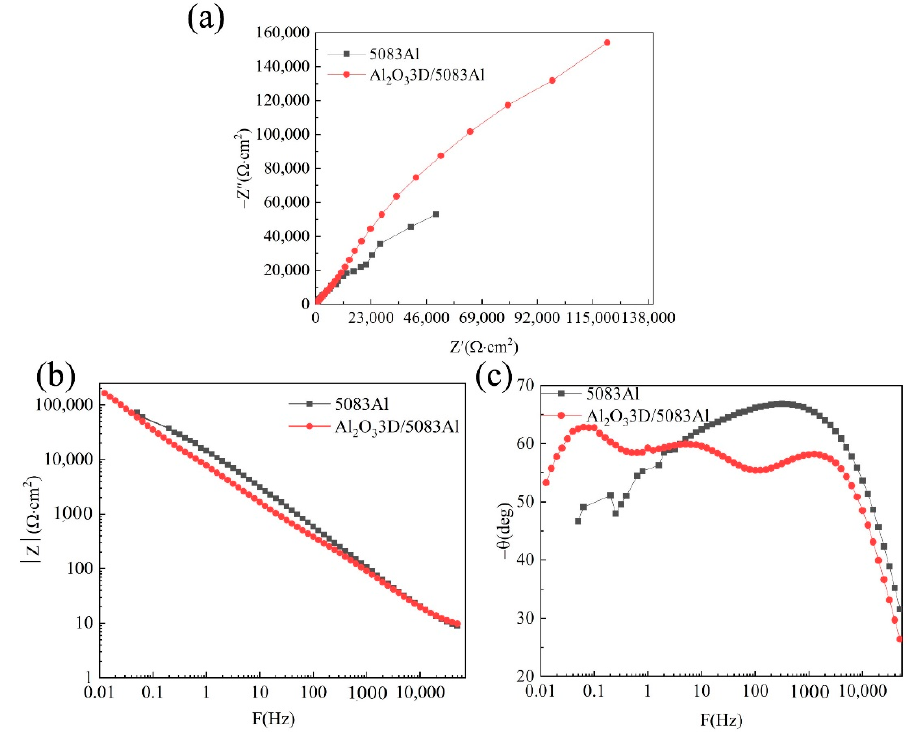
Figure 6. Uncorroded electrochemical alternating current impedance spectroscopy (EIS): ( a ) Nyquist diagram; ( b ) Bode diagram (|Z|-F); ( c ) Bode diagram ( −θ -F).